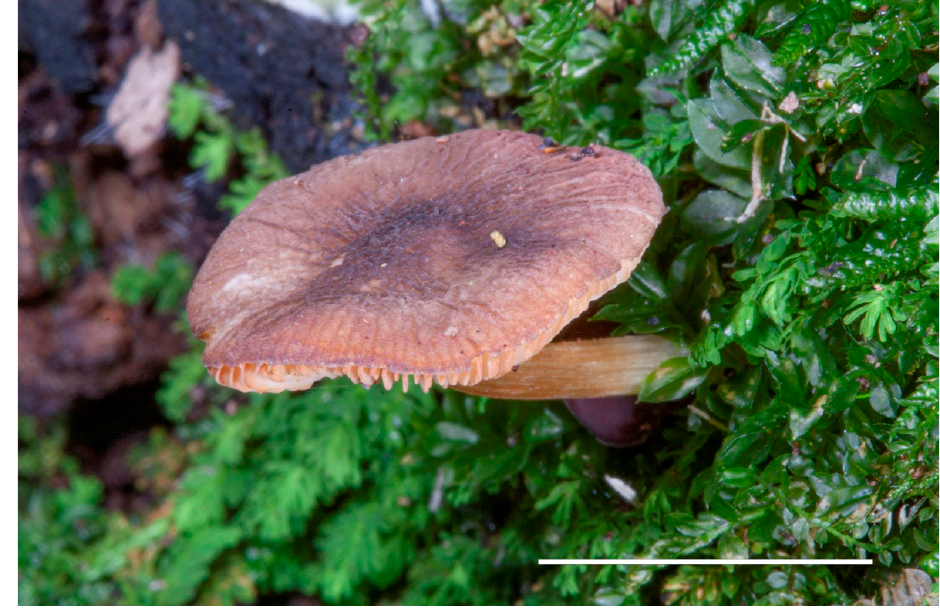
Figure 8. Pluteus flavostipitatus basidioma in situ, holotype LE 313350. Scale bar 10 mm. Notes: Pluteus flavostipitatus is characterized by rather small basidiomata with